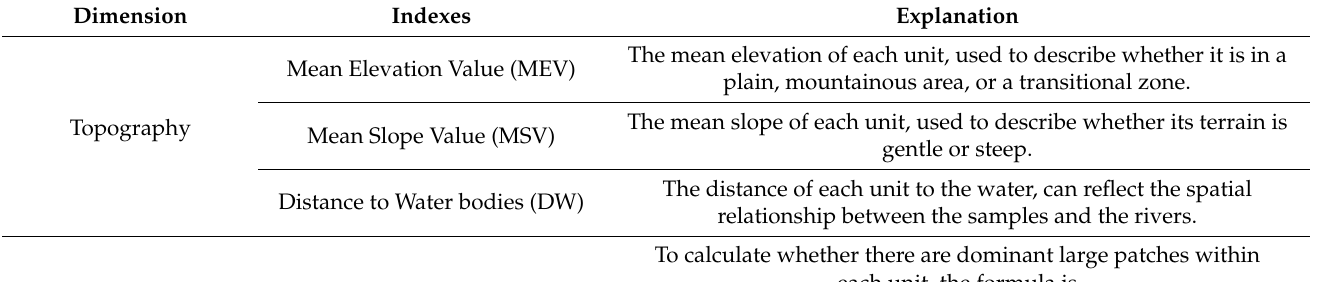
Table 3. Details of the index system to cluster